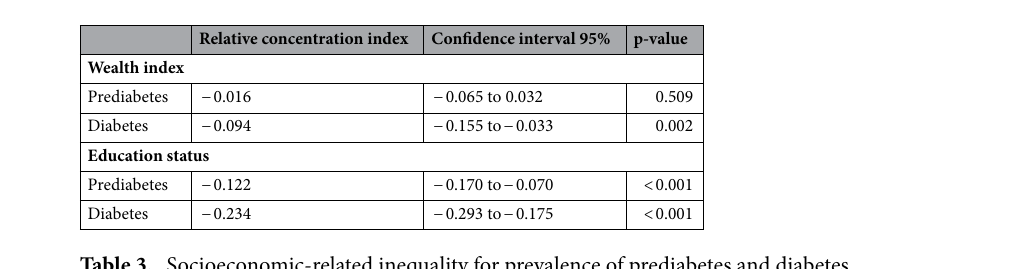
Table 3. Socioeconomic-related inequality for prevalence of prediabetes and